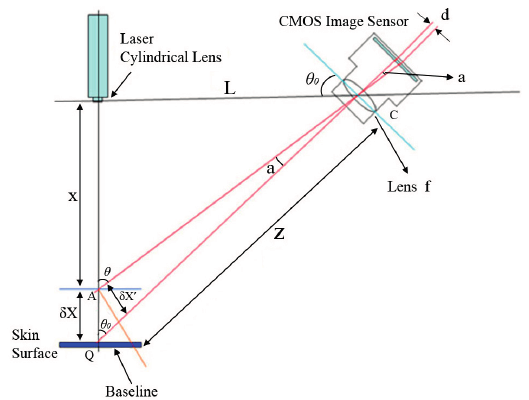
Figure 3. Schematic showing optical triangulation